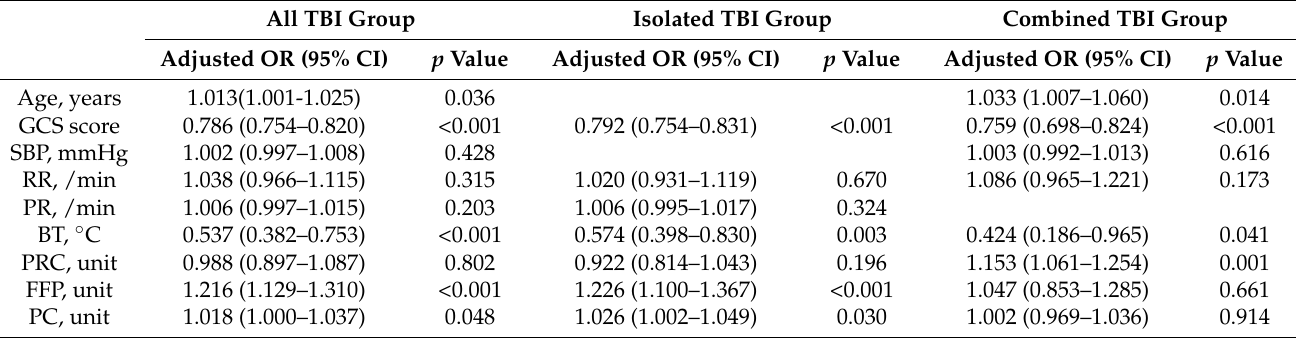
Table 6. Multivariate logistic regression analysis for predicting in-hospital mortality in TBI patients.